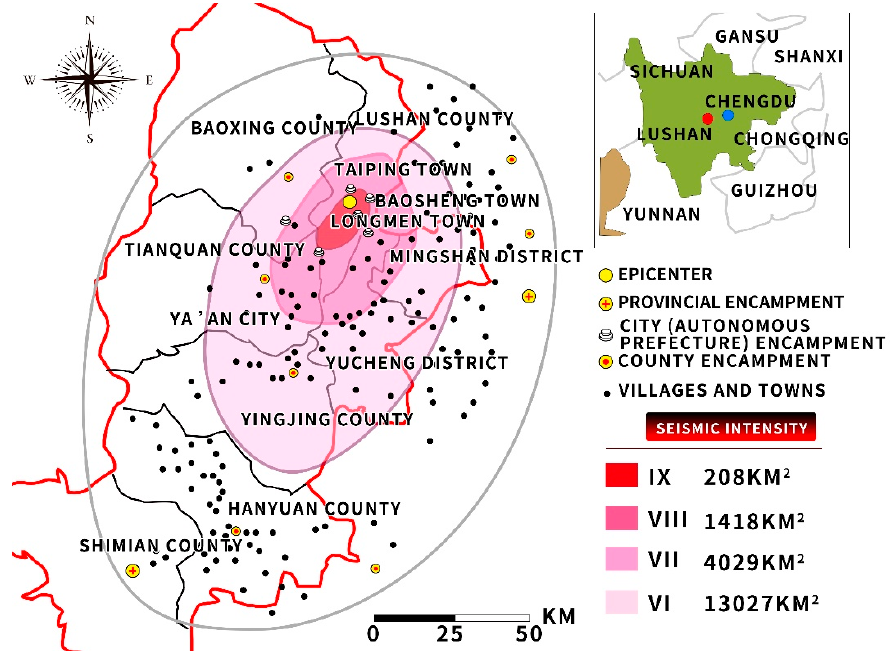
Figure 1. Study area map.